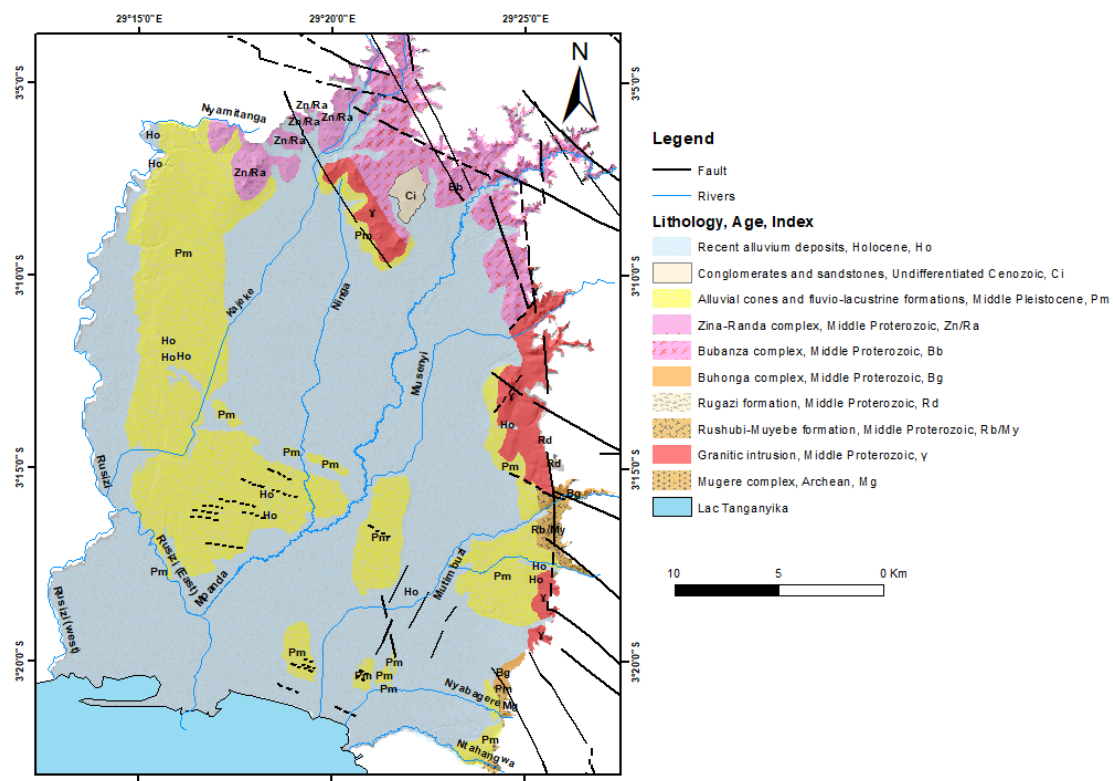
Figure 2. Geology of the study area (modified from the geological map of Burundi, Bujumbura sheet [14]).